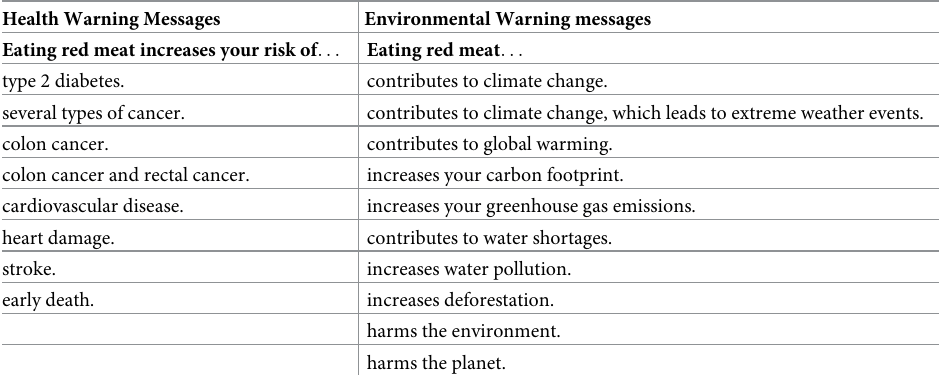
Table 2. Text of health and environmental warning messages tested in online experiment.